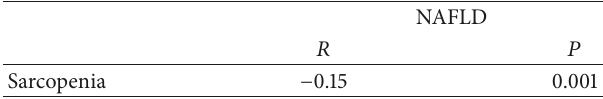
Table 2: Correlation coefficients between sarcopenia and